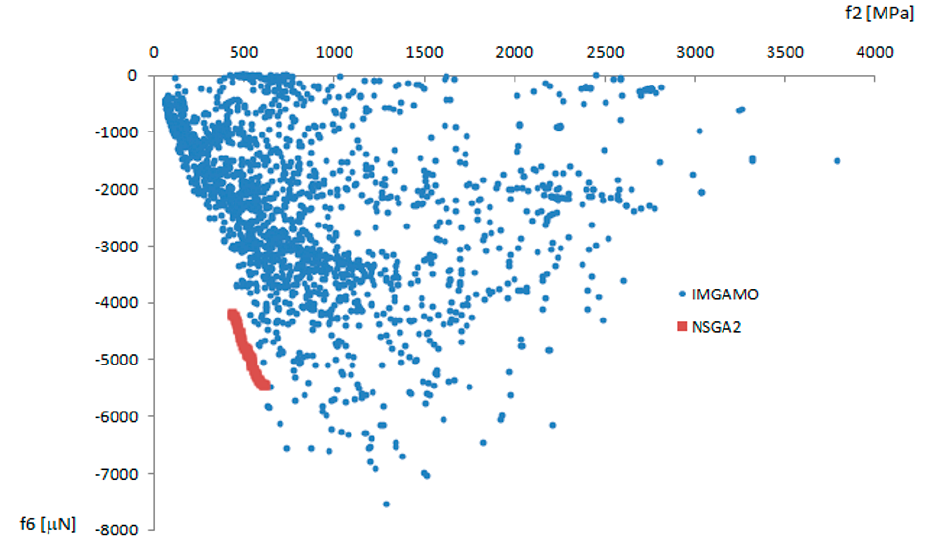
Figure 14. Comparison between Pareto front obtained by NSGAII projection plane for criteria f2 and f6 obtained by means of IMGAMO algorithm.